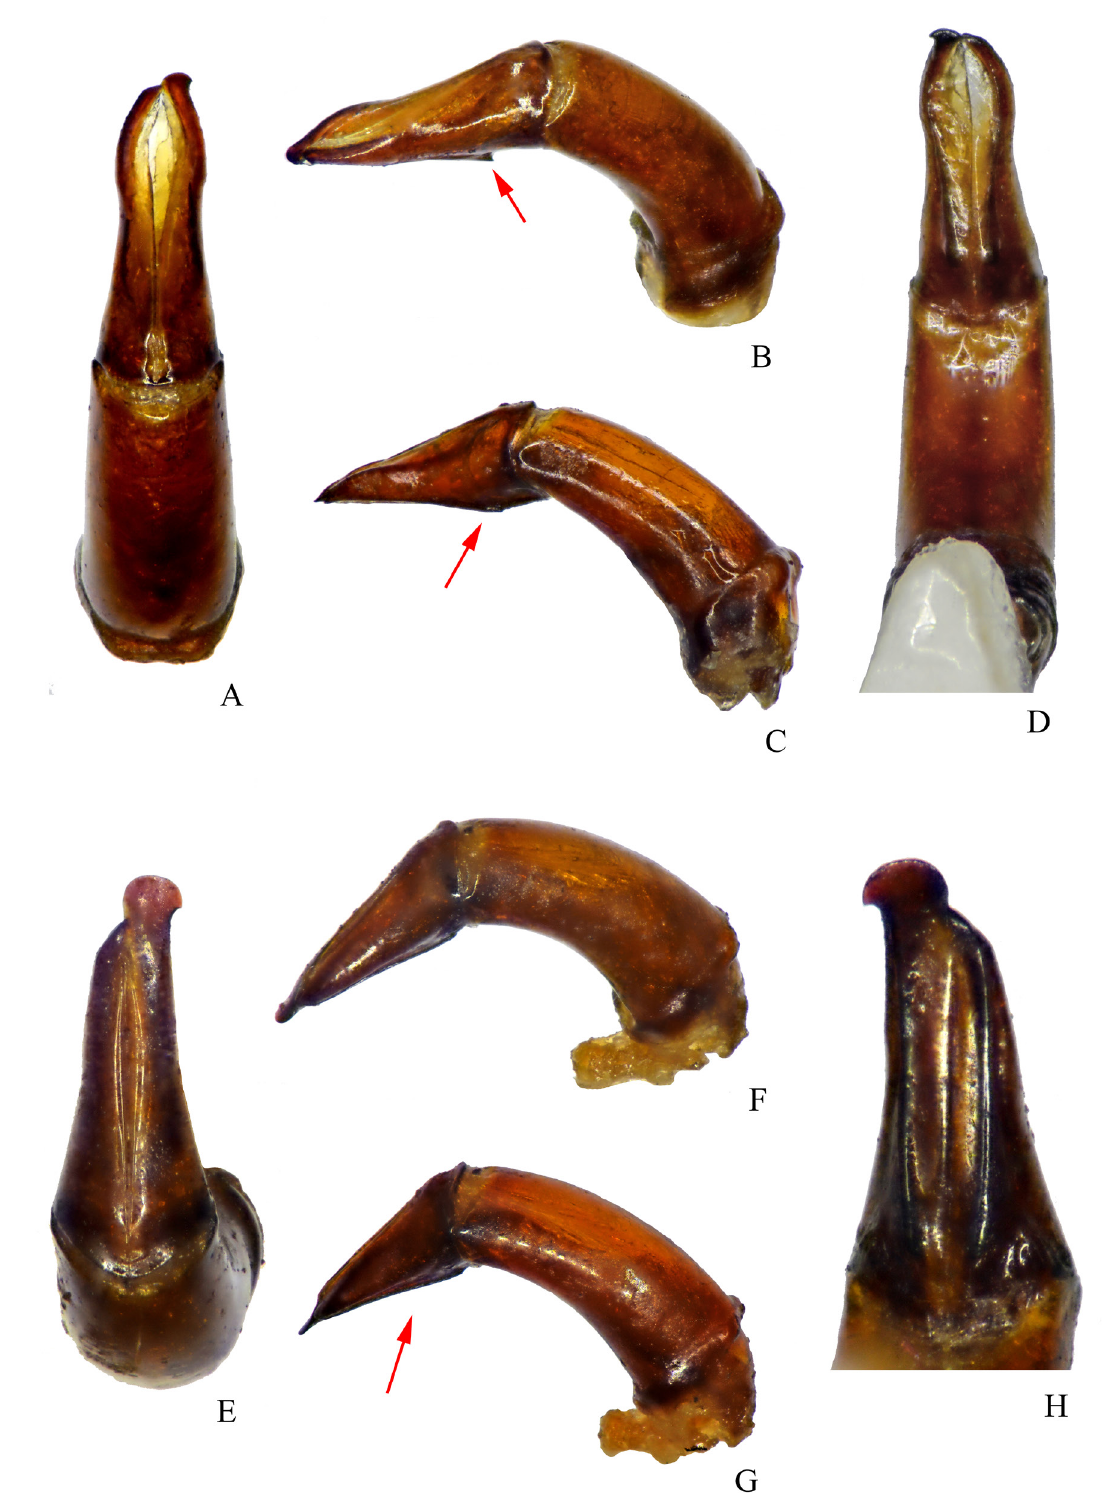
Fig. 23. Genital capsule. A‒D . Streblopus opatroides van Lansberge, 1874. A . Dorsal view. B‒C . Lateral view from slightly different angles (red arrow shows the ventral surface and its keel). D . Ventral view. E‒H . S. punctatus . (Balthasar, 1938). E . Dorsal view. F‒G . Lateral view from slightly different angles (red arrow indicates ventral surface). H . Ventral view. Observe the differences in the shape of the parameres, in particular how the apical hook is much more prominent in S. punctatus